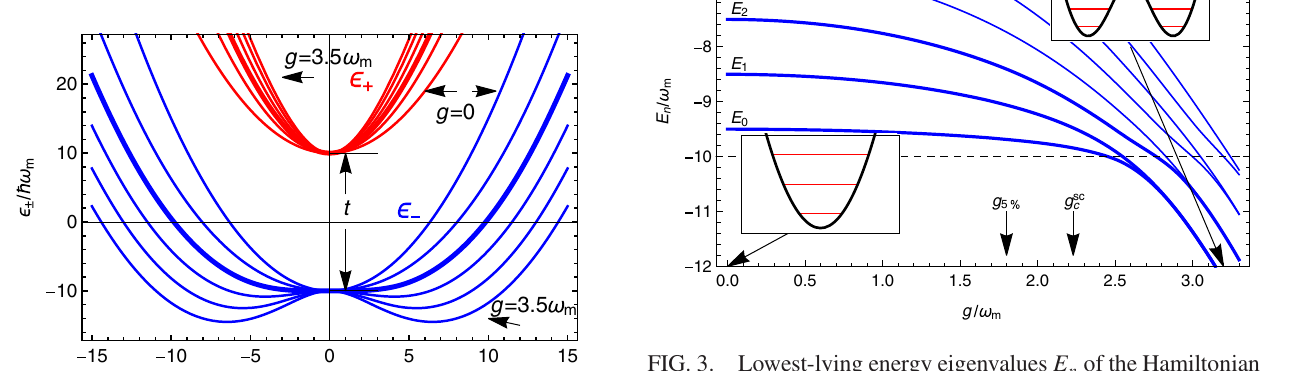
ð x Þ (red) and ε − ð x Þ (blue) from þ 2 ¼ 0 , 10, 20, 20 and the values of ð 4 g= ω m ¼ m Þ ffiffiffi p 5 ω is shown with a c ¼ m